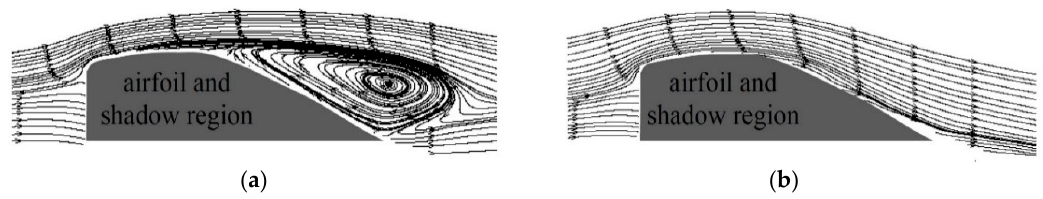
Figure 32. Mean-flow streamlines for Re = 64,200 and α = 8.7 degrees. ( a ) Uncontrolled flow and ( b ) plasma actuator at 40% chord with F + = 4.38. (Reprinted from